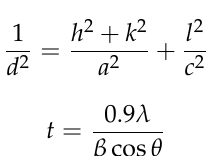
Figure 1. XRD patterns of Ba/TiO 2 , TiO 2 photoanodes along with the reference JCPDS data 21-1272. Table 1. Structural parameters derived from XRD patterns of the synthesized TiO 2 and Ba/TiO 2 pho- toanode.